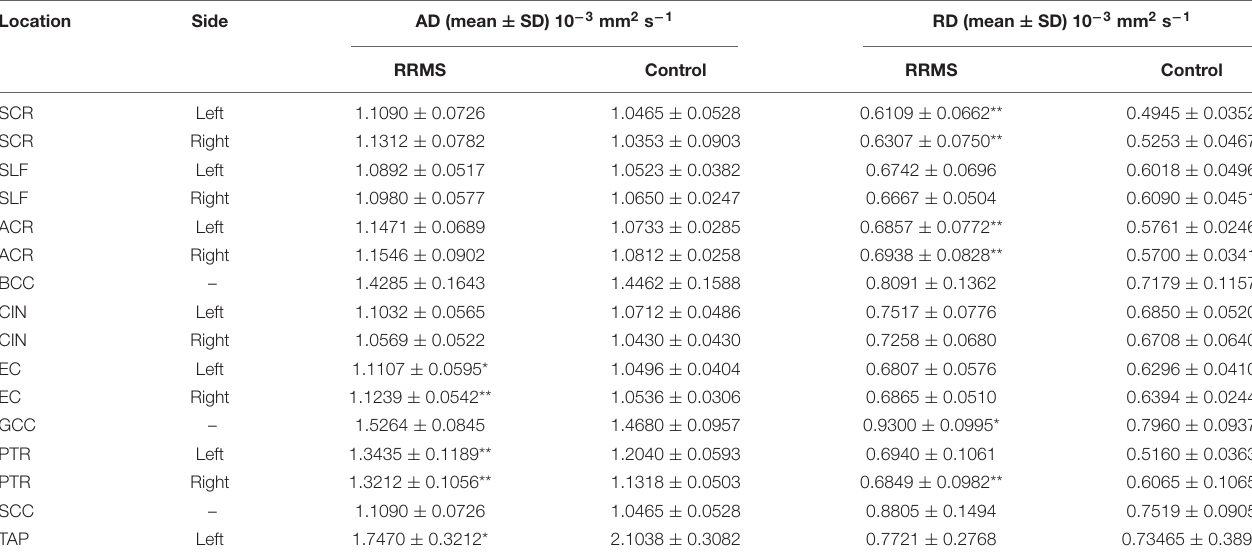
TABLE 2 | Comparison of DTI metrics of AD and RD in NAWM tracts between MS patients and controls using two-tailed Student’s t -test.